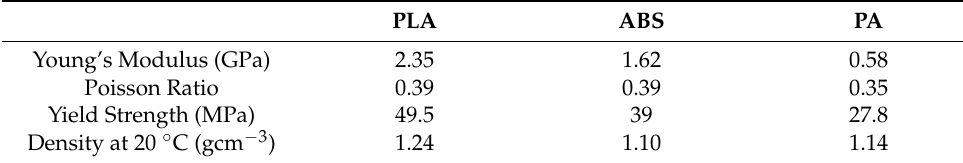
Table 1. Material properties [45].